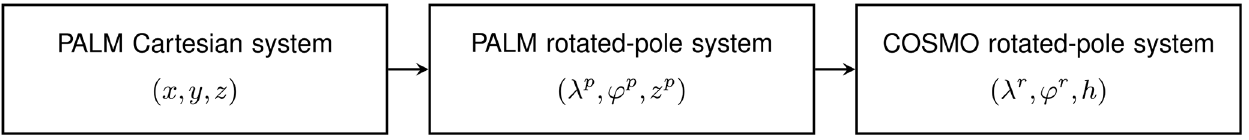
Figure 3. Coordinate systems used in INIFOR. The PALM grid coordinates are first projected onto the PALM rotated-pole system (see Eq. 5), which are then transformed to the COSMO rotated-pole system.